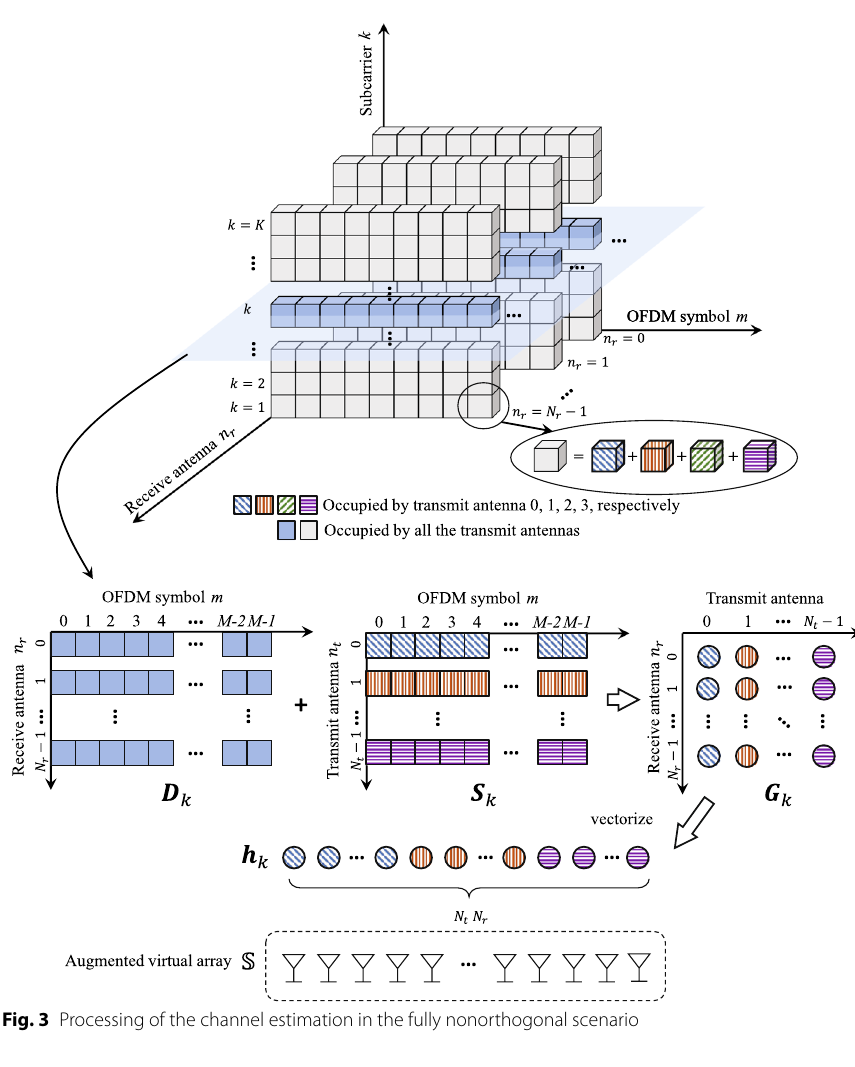
Fig. 3 Processing of the channel estimation in the fully nonorthogonal